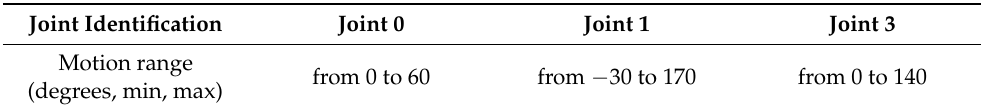
Table 4. Motion ranges of the prototype for the assumed base